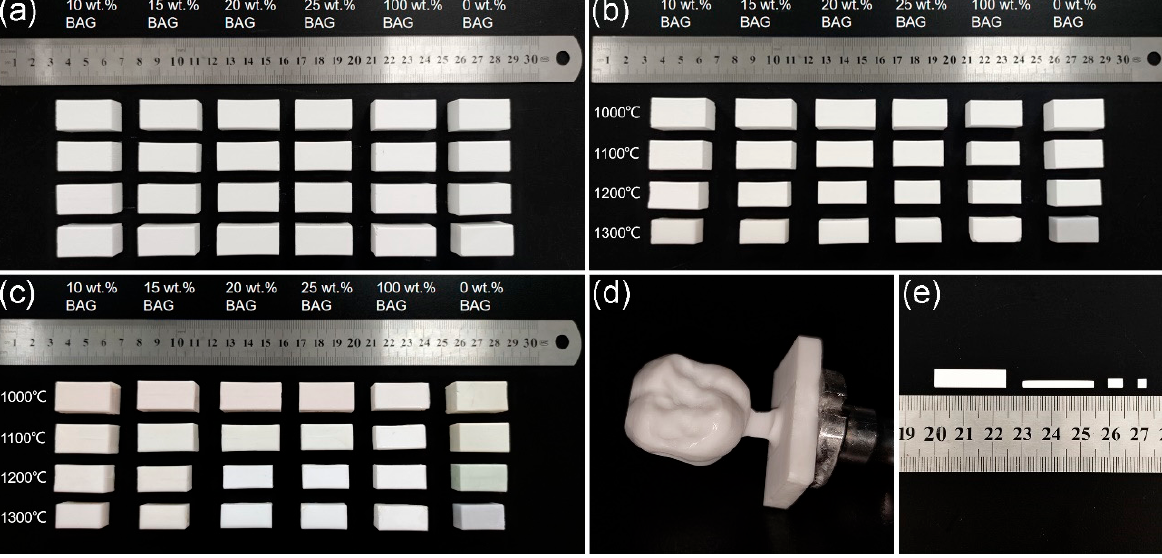
Figure 2. Macromorphologies of the specimens: ( a ) green bodies after cold isostatic pressing, ( b ) ceramic blocks after high-temperature sintering, ( c ) specimens after monomer mixtures’ infiltration and curing, ( d ) hybrid polymer–ceramic material dental crown with 20 wt.% BAG sintered at 1000 °C, and ( e ) cubic test specimens after cutting.